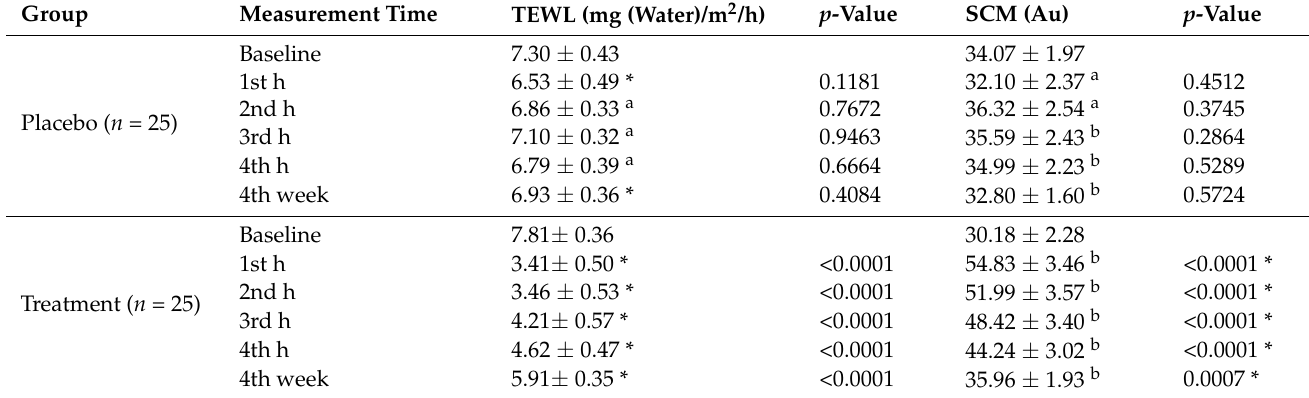
Table 2. The changes in the studied parameters within the group at different times. The values are expressed as the mean ± SE.